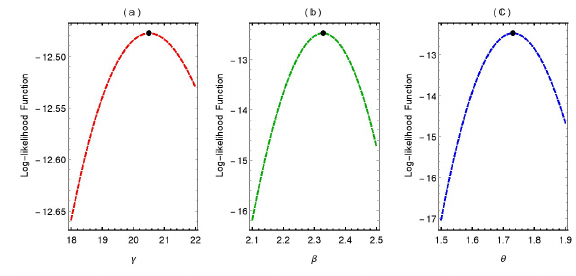
Fig. 7. Profile likelihood functions of MOPA parameters for Glass Fibers data.